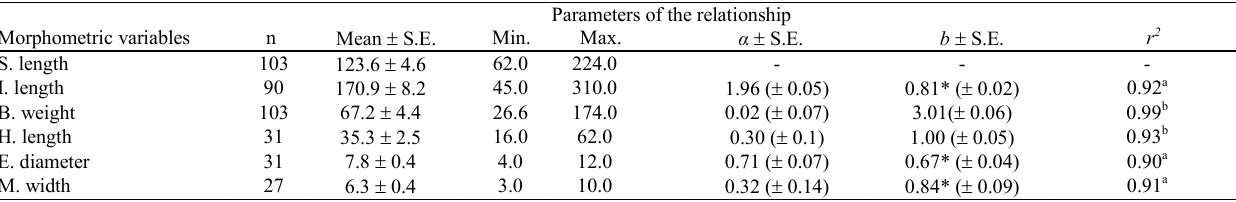
Table 4. Morphometric traits measured for Iheringichthys labrosus . n= number of individuals considered for measures, max = maximum, min = minimum, a = intercept of relationship, b = slope of relationship, S.E. = standard error, r 2 = coefficient of determination. *significantly different ( t -test; P <0.05) allometric coefficient values ( b ) compared with the b values assuming isometric growth ( b =1 or b =3, for length-length and length-weight relationships); a Allometric negative growth; b Isometric growth. Parameters of the relationship Morphometric